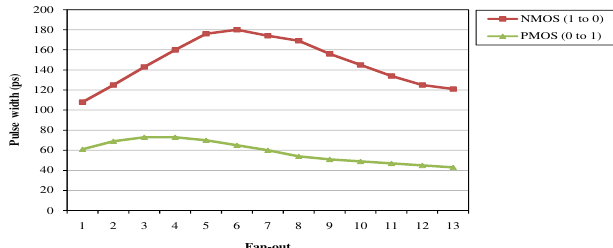
Figure 2. Pulse widths for various fan-out when NMOS and PMOS is